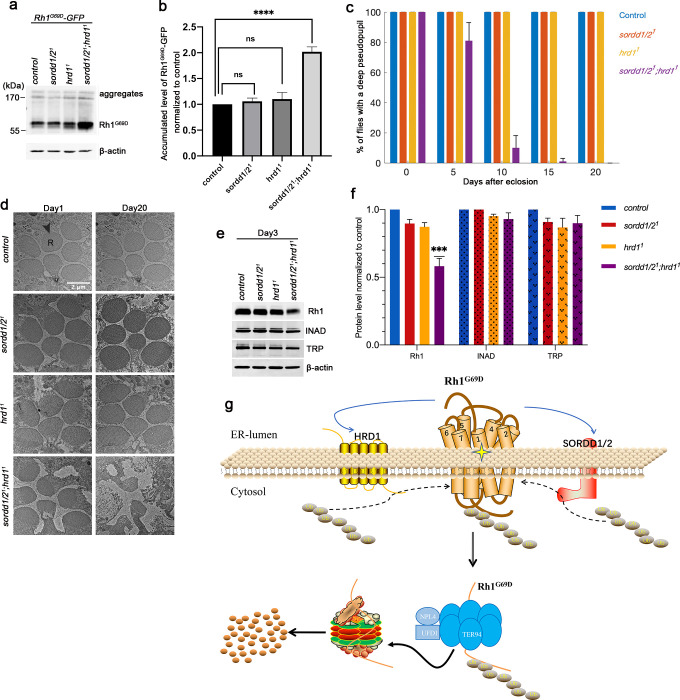
SORDD1/2 and Hrd1 function redundantly in promoting Rh1G69D degradation.(a) Western blot shows Rh1G69D-GFP accumulation in sordd1/21; hrd11 double mutants (ey-flp sordd1/21;FRT82B ninaE-Rh1G69D-GFP hrd11/FRT82B GMR-hid CL), compared to sordd1/21 (sordd1/21;ninaE-Rh1G69D-GFP) and hrd11 (ey-flp;FRT82B ninaE-Rh1G69D-GFP hrd11/FRT82B GMR-hid CL) mutant alone. Rh1G69D-GFP is driven by an endogenous ninaE promoter. The higher molecular weight of Rh1G69D aggregates could be seen at the top of the lanes. (b) Quantification of a, error bars indicate SEM; n = 3, ns, not significant, ****p<0.0001 (ANOVA, Sidak's multiple comparisons test). (c) Quantification of the percentage of the deep pseudopupil in control (ey-flp;FRT82B), sordd1/21, hrd11 (ey-flp;FRT82B hrd11/FRT82B GMR-hid CL) and sordd1/21;hrd11 (ey-flp sordd1/21;FRT82B hrd11/FRT82B GMR-hid CL) flies at 0, 5, 10, 15 and 20 days old. At least ~100 flies in 3 groups were measured for each genotype. Error bars indicate SEM. (d) TEM images of 1-day-old and 20-day-old adult eye tangential sections. Genotypes are as indicated on the left side of the panels. R, rhabdomere. Scale bar, 2 μm. The sordd1/21;hrd11 double mutant flies show severe degeneration of photoreceptor cells at age of 20 days. All flies are in white eye background, and raised under 12 h light /12 h dark cycles. (e) Western blot analysis of Rh1, TRP, and INAD in control, sordd1/21, hrd11, and sordd1/21;hrd11 flies at 3 days old. (f) Quantification of relative protein levels of Rh1, TRP, and INAD in e; error bars indicate SEM (n = 3); ***p<0.001 (one-way ANOVA, Sidak's multiple comparisons test). (g) Proposed model of SORDD1/2 in the degradation of misfolded Rh1G69D parallel to HRD1 complex.